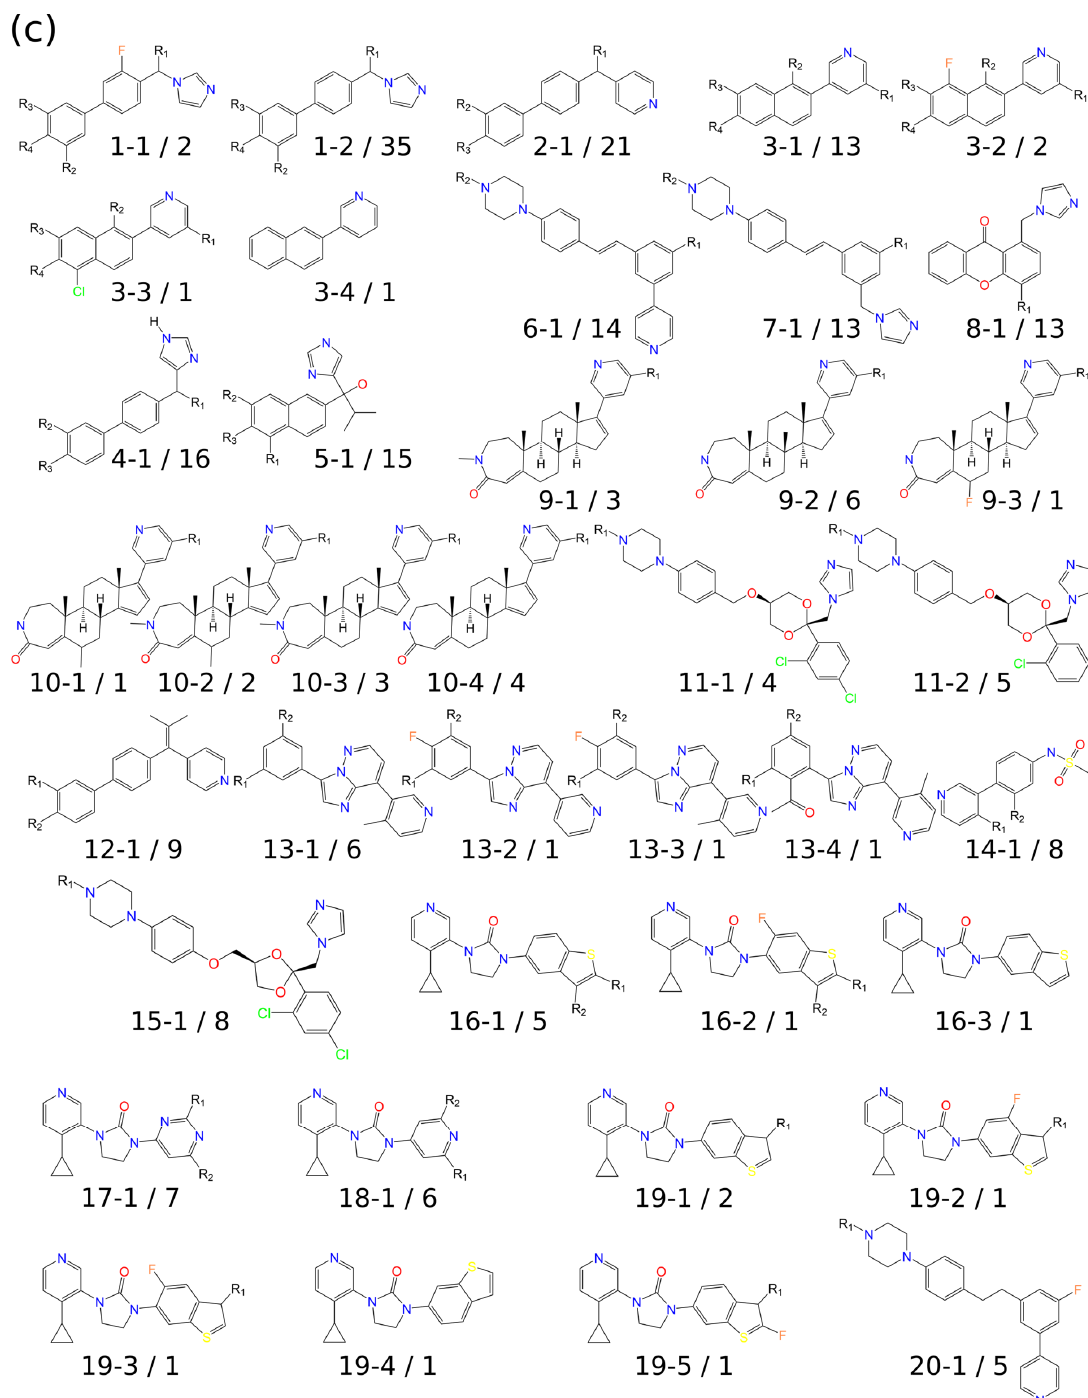
Figure 4. Scaffold analysis of nonsteroidal inhibitors. ( a ) Murcko scaffold vs. pIC 50 as a scatter plot for 683 nonsteroidal inhibitors. Only Murcko frequencies that are ≥ 10 are demonstrated, and the complete scatter plot is shown in Figure S1 from the SI. ( b ) Representative scaffolds with either a frequency ≥ 10 or EF ≥ 1. Scaffolds are labeled as XX/YY/ZZ, where XX, YY, and ZZ denote the scaffold’s ID, EF, and the frequency of occurrence, respectively. ( c ) Detailed list of Murcko ‐ based core fragments from representative Murcko scaffolds. Fragments are labeled with the scaffold ID, core fragment ID, and the occurrence frequency (scaffold ID—core fragment ID/frequency).